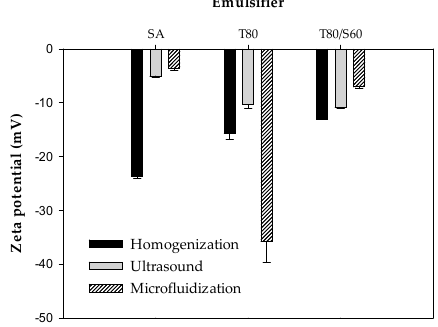
Figure 3. Effect of emulsifier type (SA: stearic acid; T80: Tween 80; T80/S60: Tween 80/Span 60) and shear process (homogenization, ultrasound and microfluidization) on the ζ -potential of beeswax-starch nanoemulsions.